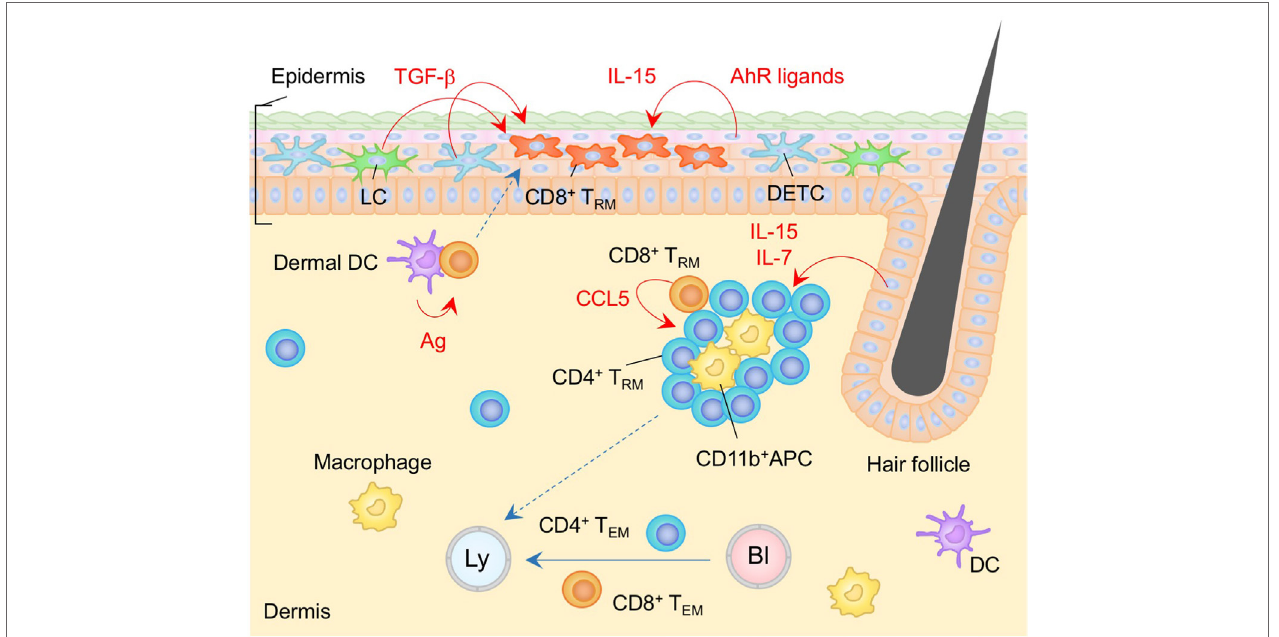
FiGURe 1 | T RM niches in the skin. Langerhans cells (LC), dendritic epidermal T cells (DETC) expressing γδ T cell receptors, and CD8 + T RM cells are maintained in the epidermis. CD8 + T RM cells displace epidermal niches originally occupied by DETC at the site of infection. Transforming growth factor (TGF)- β secreted from LC and DETC, IL-15, and aryl hydrocarbon receptor (AhR) ligands play a role in the generation and maintenance of epidermal CD8 + T RM cells. Memory CD4 + T cells in the dermis form clusters with CD11b + APC around the hair follicles. CCL5 secreted from peri-collicular CD8 + T cells promotes formation of clusters. Although most memory CD4 + T cells in the cluster exhibit canonical T RM phenotypes, long-period parabiosis experiments revealed that this population is slowly replenished by cells from the circulation. IL-7 and IL-15 secreted from keratinocytes in the hair follicles promote T cell persistence in the cluster. T EM cells are passing through the dermis. Orange and blue cells indicate CD8 + and CD4 + T RM cells, respectively, unless otherwise stated. Red lines indicate the representative niche factors that influence the maintenance of T RM cells. Blue lines indicate the migratory routes. Dashed lines indicate potential impact of niche factors (red) or migratory routes (blue). Abbreviations: Ly, lymph vessel; Bl, blood vessel; Ag, antigen; APC, antigen-presenting cell; T RM , tissue-resident memory T cells; T EM , effector memory T